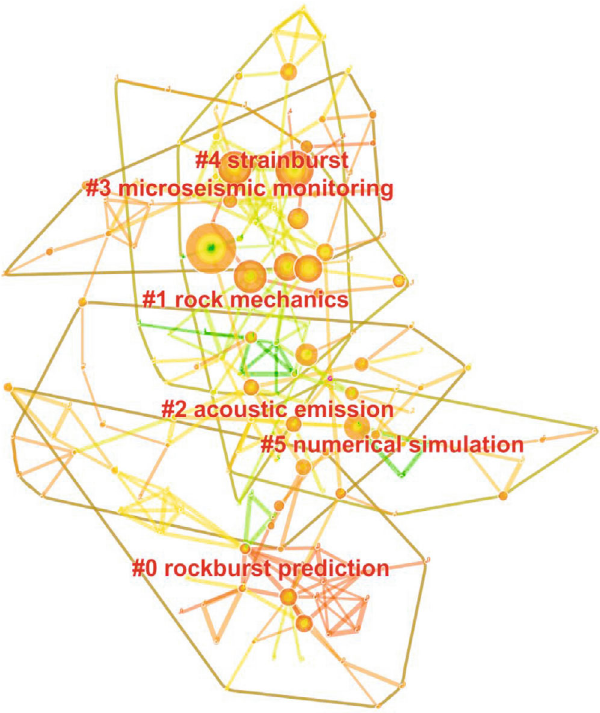
Figure 14: Main clusters in rockburst research of hard rock.